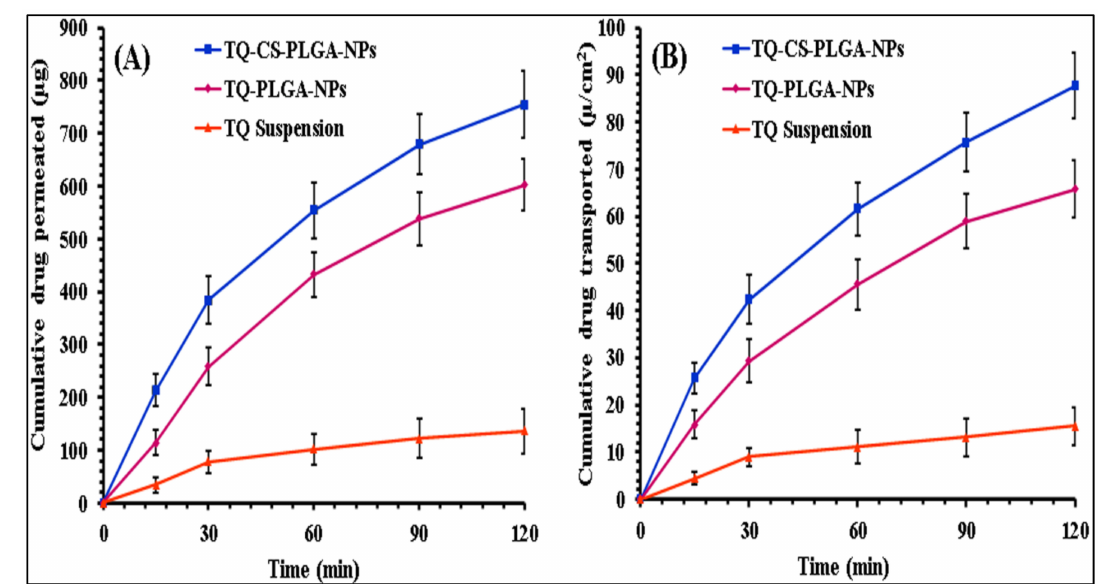
Figure 9. Ex vivo intestinal permeation study result showing: ( A ) cumulative amount of drug permeated ( µ g) vs. time, ( B ) cumulative drug transported ( µ g cm − 2 ) vs.